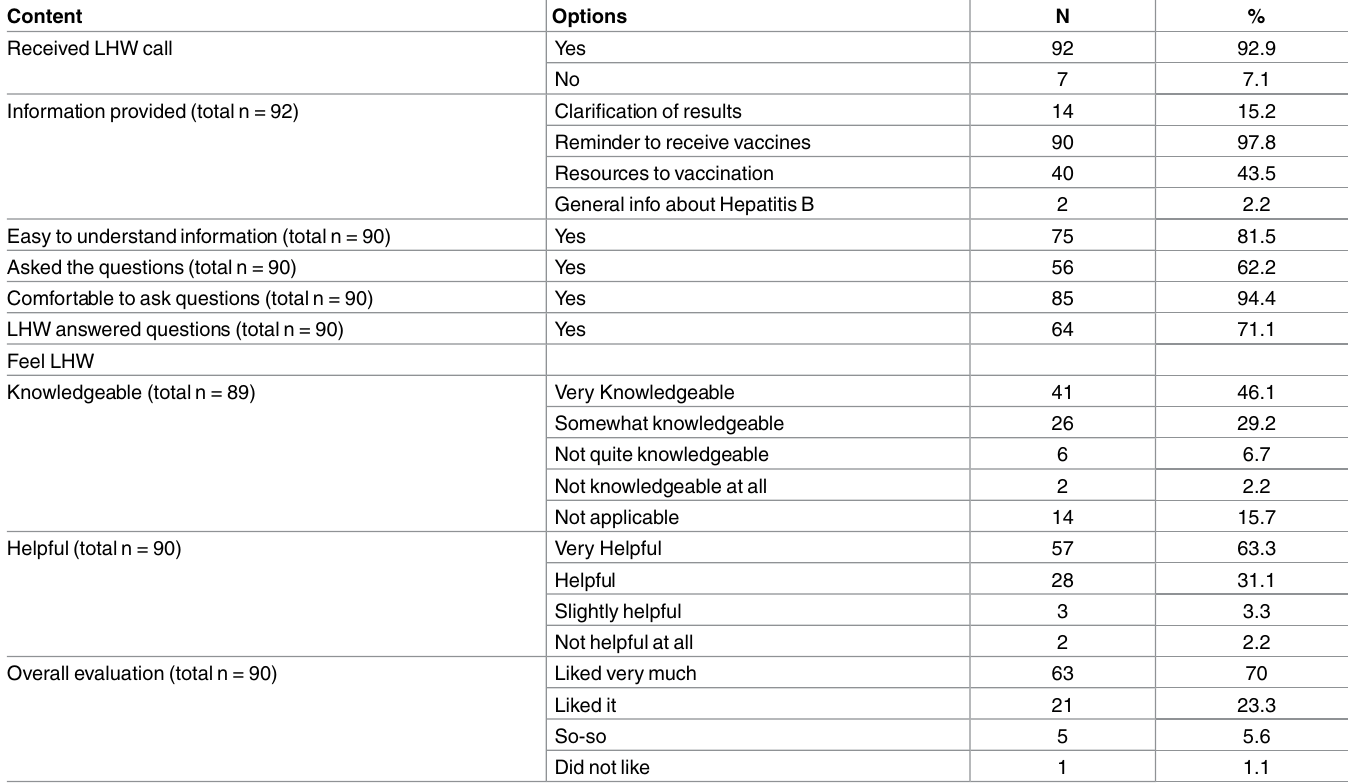
Table 4. Participants’ evaluation of LHW interventionamongthosein the intervention group (n =